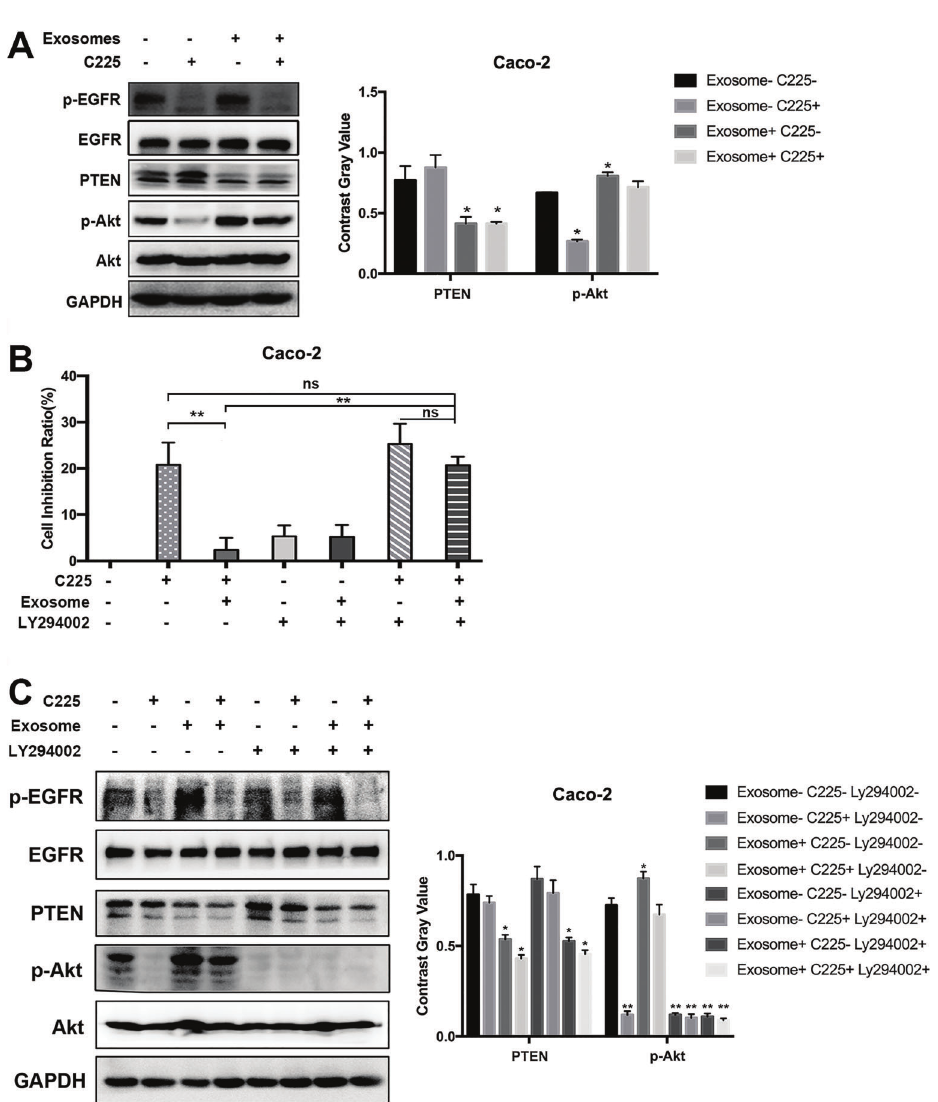
Figure 4. RKO-derived exosomes induced cetuximab resistance in Caco-2 cells via the PTEN/Akt pathway. A , Western blot was used to detect the expression levels of p-EGFR, EGFR, p-Akt, Akt, PTEN, and GAPDH in Caco-2 cells treated with cetuximab (10 m g/mL) for 48 h after pre-treatment with RKO-derived exosomes (50 m g/mL) for 48 h. B , The MTT assay showed that the Akt inhibitor LY294002 reversed the RKO-derived exosome induced C225 drug resistance in Caco-2 cells. Data are reported as means ± SD. *P o 0.05, **P o 0.01 (one-way ANOVA, with Tukey post hoc test). C , Western blot was used to assess the changes of p-EGFR, EGFR, PTEN, phosphor-Akt, and Akt expression levels in Caco-2 cells treated with the Akt inhibitor LY294002. Data are reported as means ± SD. *P o 0.05, **P o 0.01, compared to control (one-way ANOVA, with Dunnett ’ s post hoc